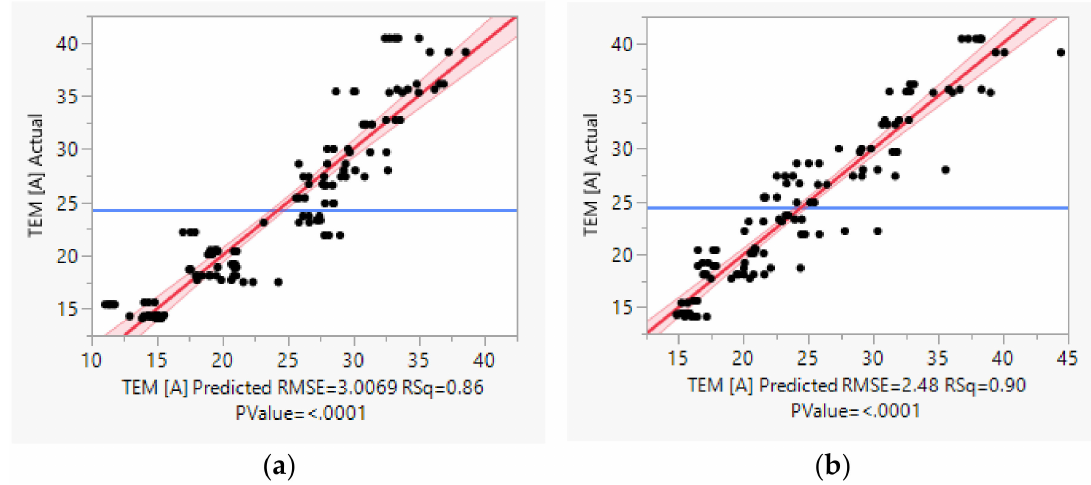
Figure 10. Model prediction results for Equation (3) ( a ), with parameters: a 0 = 23.17; a 1 = 0.86; a 2 = − 19.90; a 3 = 18.03; and for Equation (4) ( b ), with parameters: a 0 = 10.32; a 1 = 1.52; a 2 = − 7.64; a 3 =